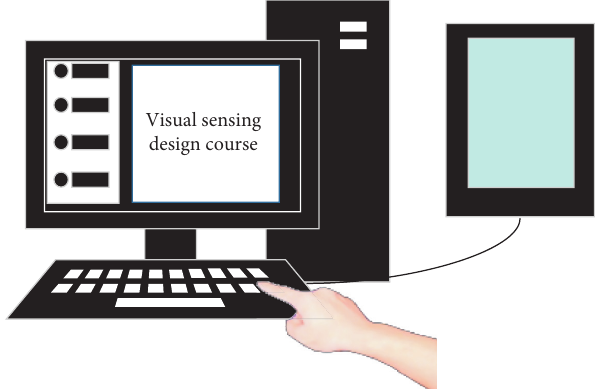
Figure 10: Interactive learning example